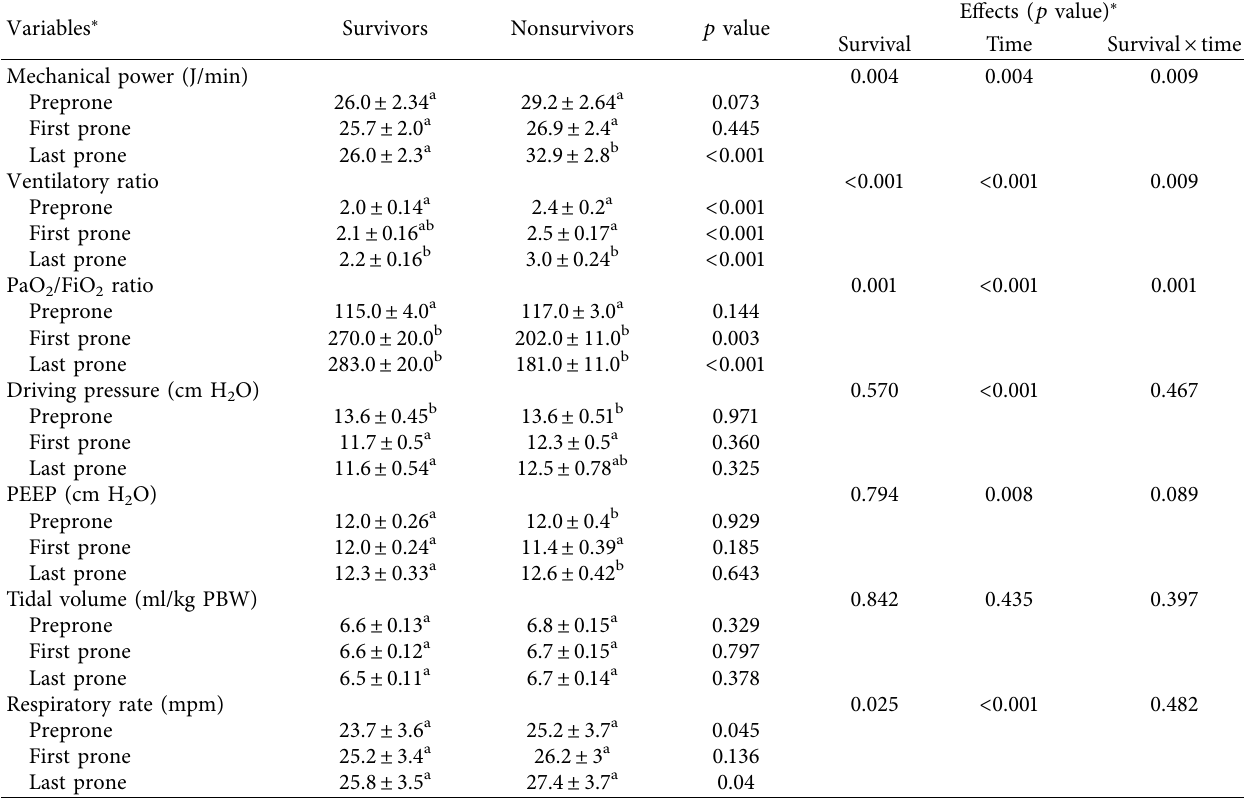
Table 2: Ventilatory settings and monitoring parameters during pre-, frst-, and last-prone sessions. Variables